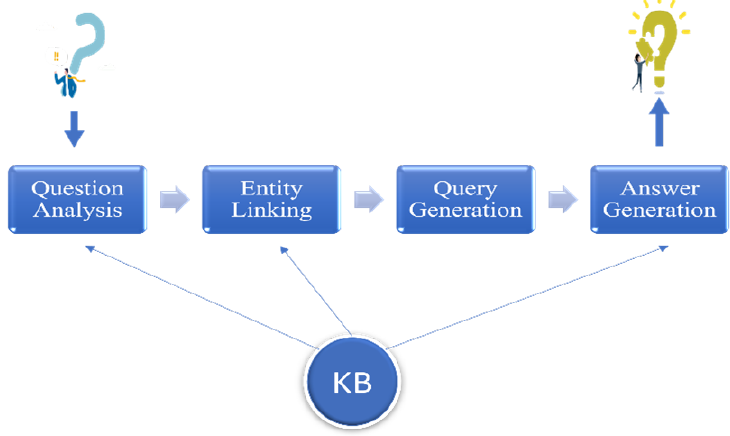
Figure 18. Semantic Parsing